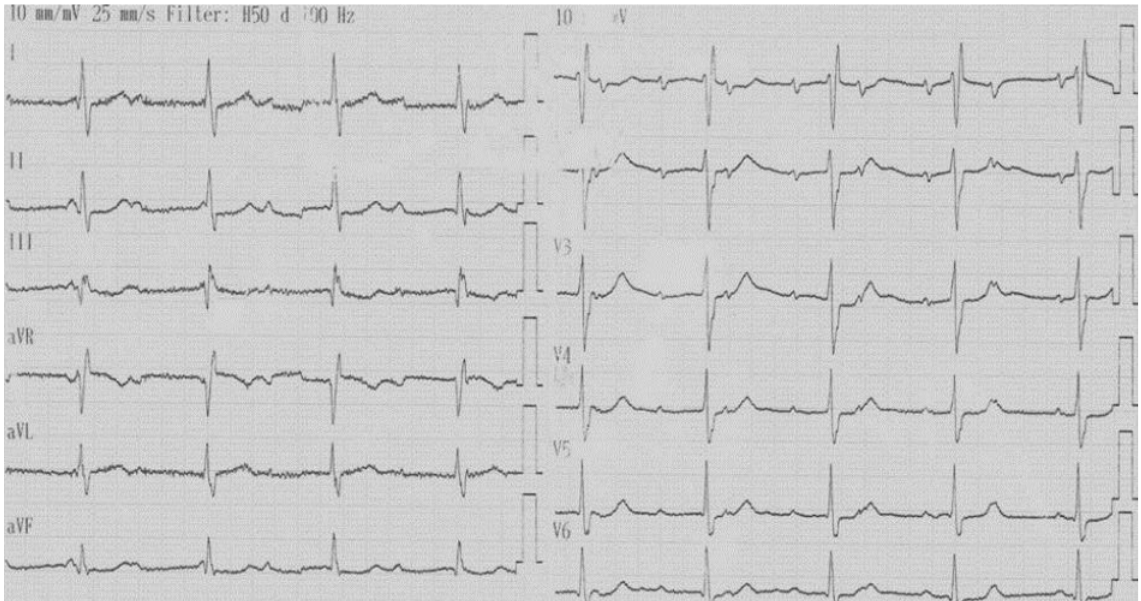
Figure 1. 12-lead ECG on admission showing a 3-d degree heart block.